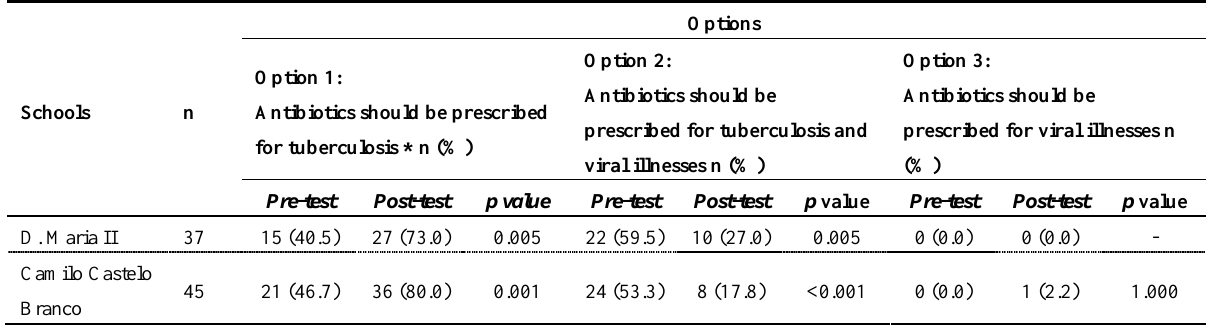
Table 2. Number of positive answers to questions on antibiotic use against viral illnessess (influenza, hepatitis, AIDS) and tuberculosis.